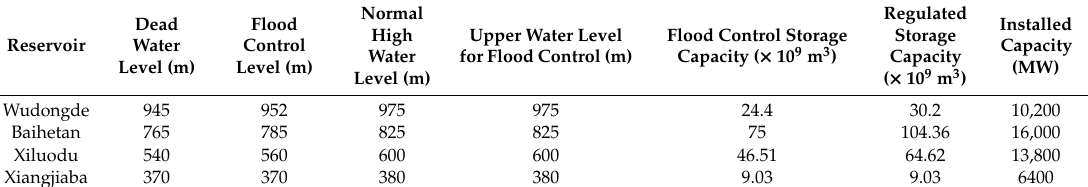
Table 1. The engineering characteristics of the Jinsha River downstream cascade reservoirs.